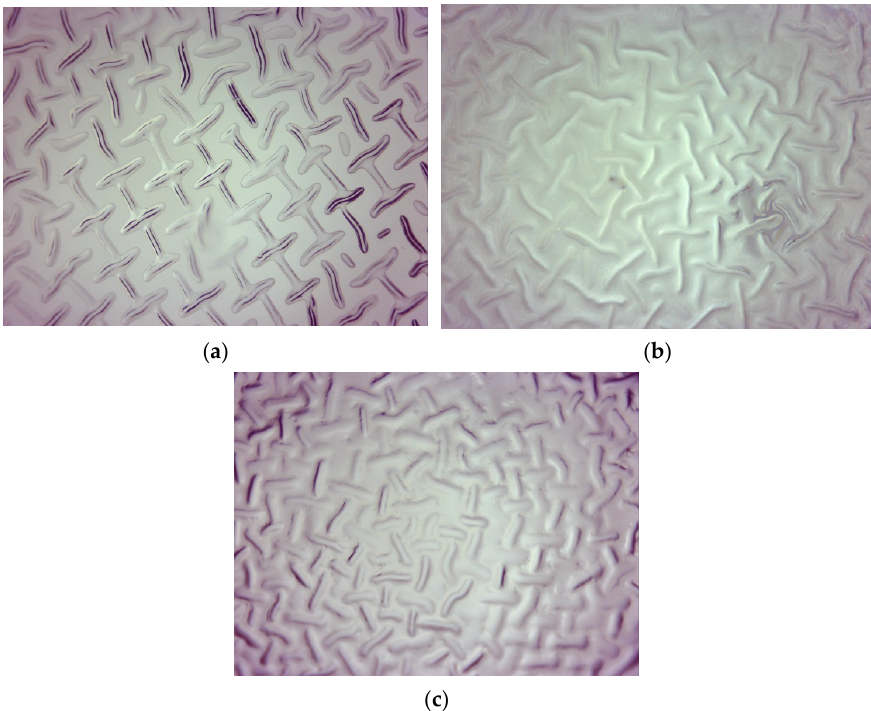
Figure 2. Optical image of sample 700/7.5 ( a ), 700/10.0 ( b ), and 700/12.5 ( c ). Observations using the optical microscope showed how the amount of the crosslinking agent used during the hydrogels’ synthesis affected their surface morphology. Based on the optical images, it may be noticed that as the amount of the crosslinker in the polymer matrix increased, the concentration of minor irregularities resulting from the polymers’ drying also increased. Importantly, clear differences between the surface morphology of samples 575/12.5 and 700/7.5 may be reported. Next, the observed irregularities on the surface of hydrogels obtained using a crosslinking agent with higher average molecular weight have larger dimensions than these ones observed on the surface of hydrogels prepared using PEGDA 575. It may also be observed that as the amount of the crosslinker in the polymer material increased, the structure of such a polymer became more wrinkled. Importantly, the analysis via the optical microscopy was aimed only at generally observing the differences in the hydrogels’ surface morphology. In the next step of the research, a digital microscope was applied to characterize the hydrogels’ morphology as well as their roughness in more detail. The images obtained are presented below in Figures 3–8.